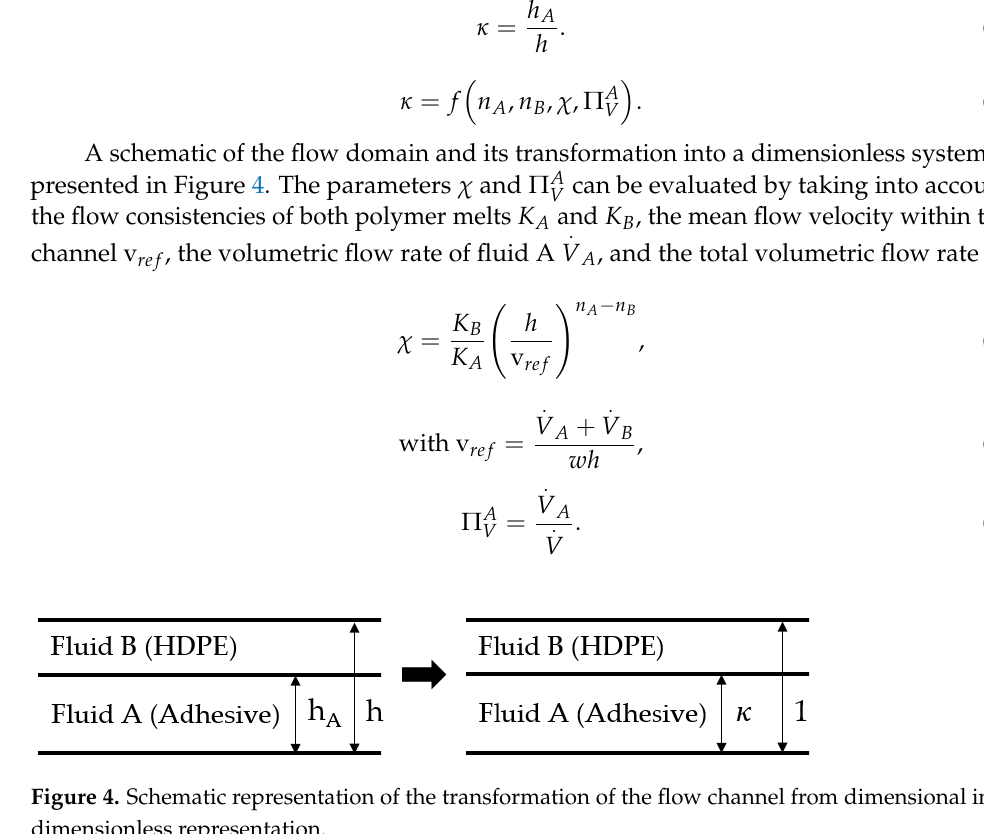
Table 6. Specifications of the spectral domain OCT system.